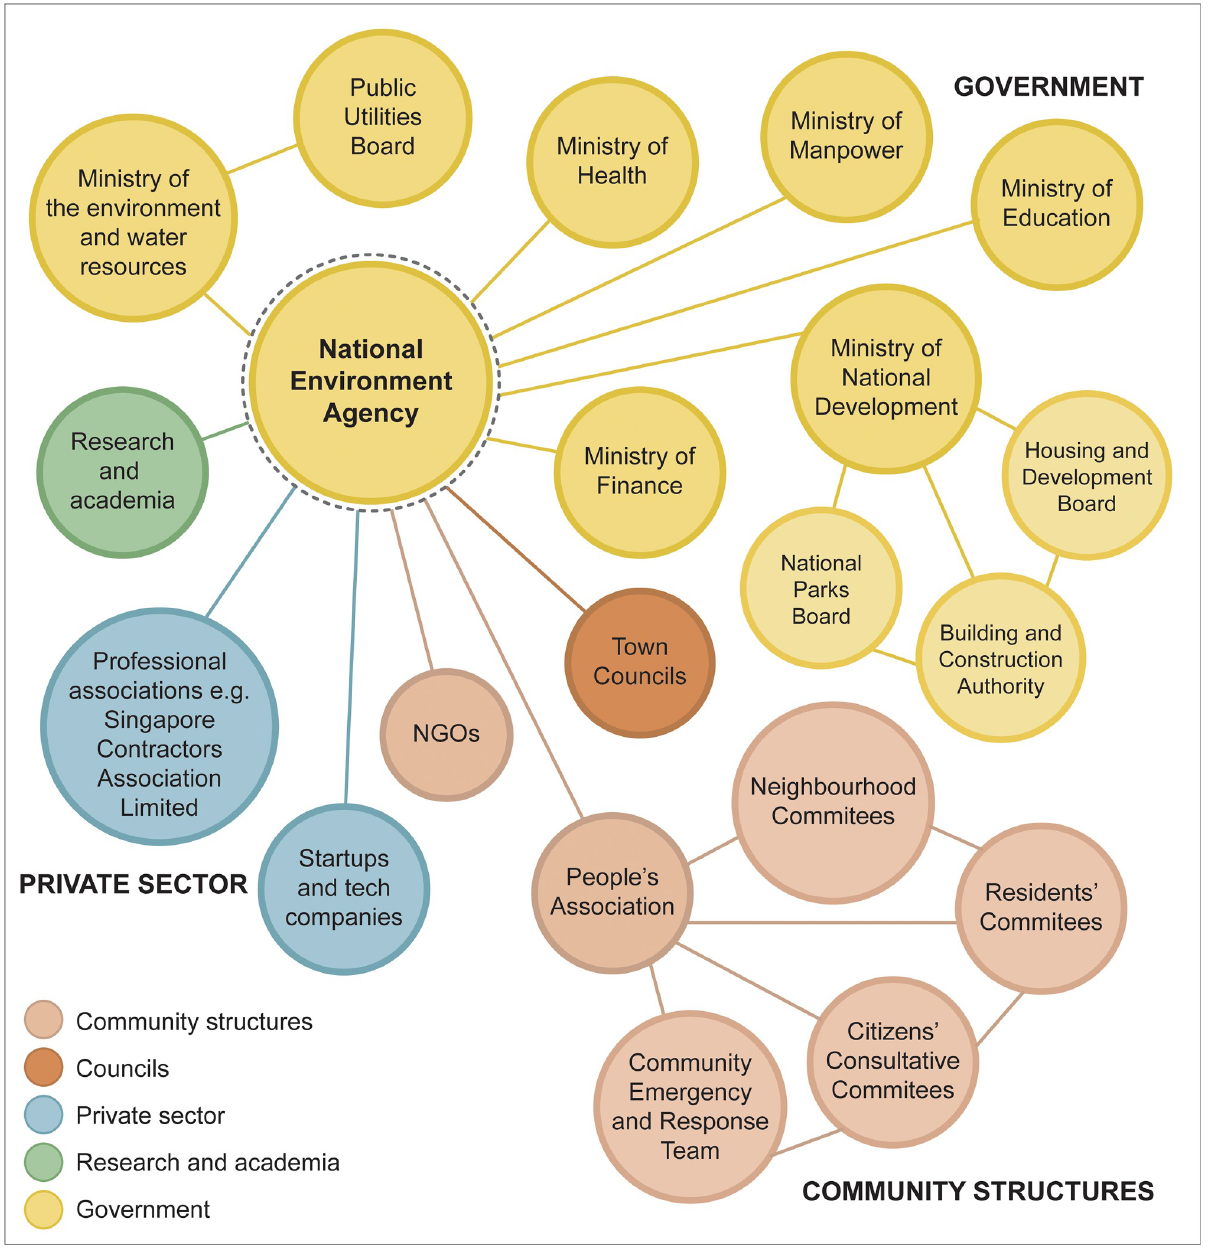
Fig 2. Collaboration between National Environment Agency and other sectoral stakeholders. NGO, nongovernmental organisation.